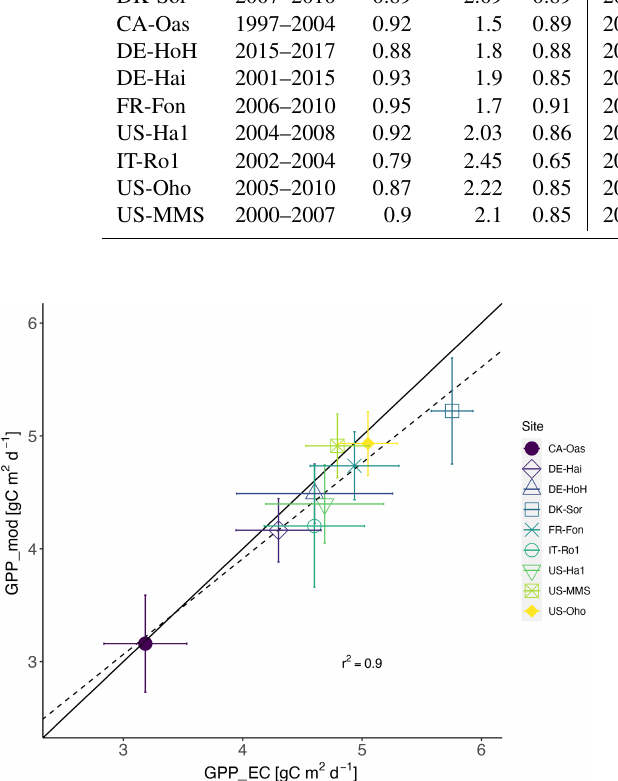
Figure 6. Estimated GPP based on flux tower measurements vs. modeled GPP ± 1 standard deviation (error bars) across the 9 stud- ied sites. The solid line indicates the 1 : 1 line, and the dashed line indicates the regression line. Each dot represents one of the sites and refers to site-averaged GPP over the entire available time series.